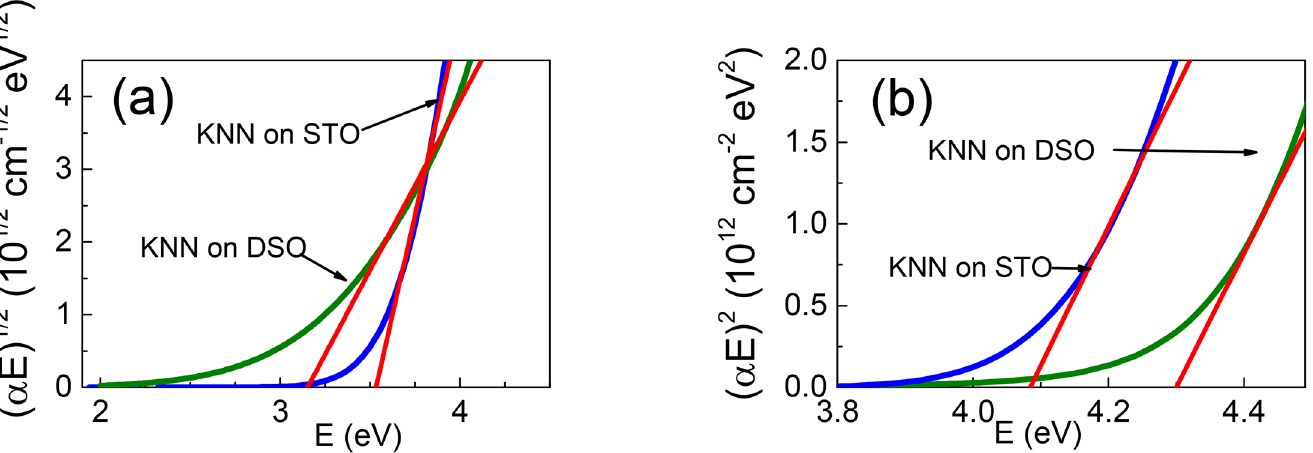
Fig 6. Tauc plots for (a) indirect and (b) direct optical transitions in the KNNO films.